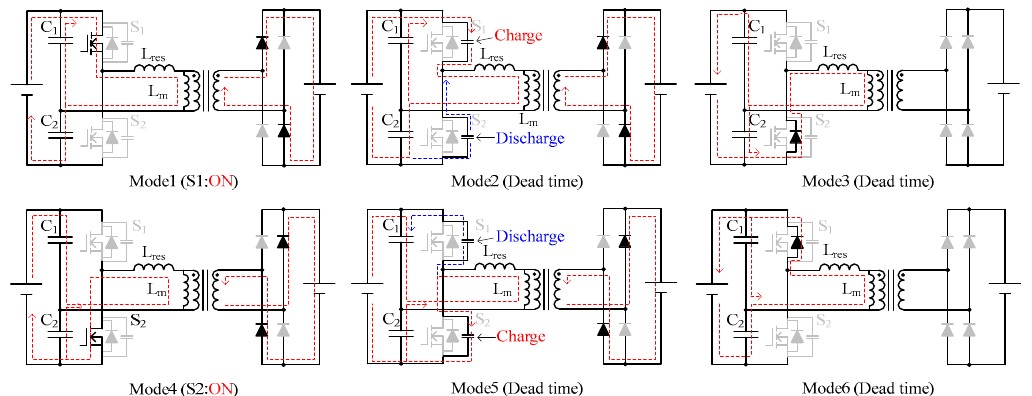
Figure 5. Operation mode of LLC resonant converter.